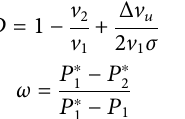
FIGURE 2 | Pro fi les with different cambers and maximum thickness locations (A) θ (cid:1) 40 ° ; (B) θ (cid:1) 44 ° ; (C) θ (cid:1) 46 ° .